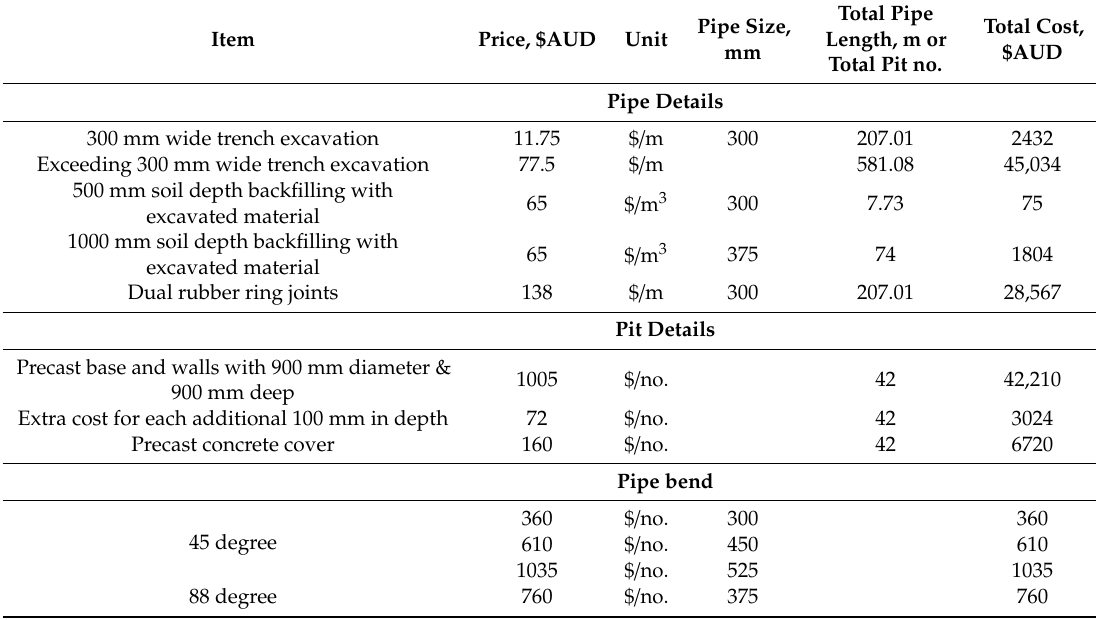
Table 6. Cost of di ff erent items of the conventional drainage system (pipe and pit network).